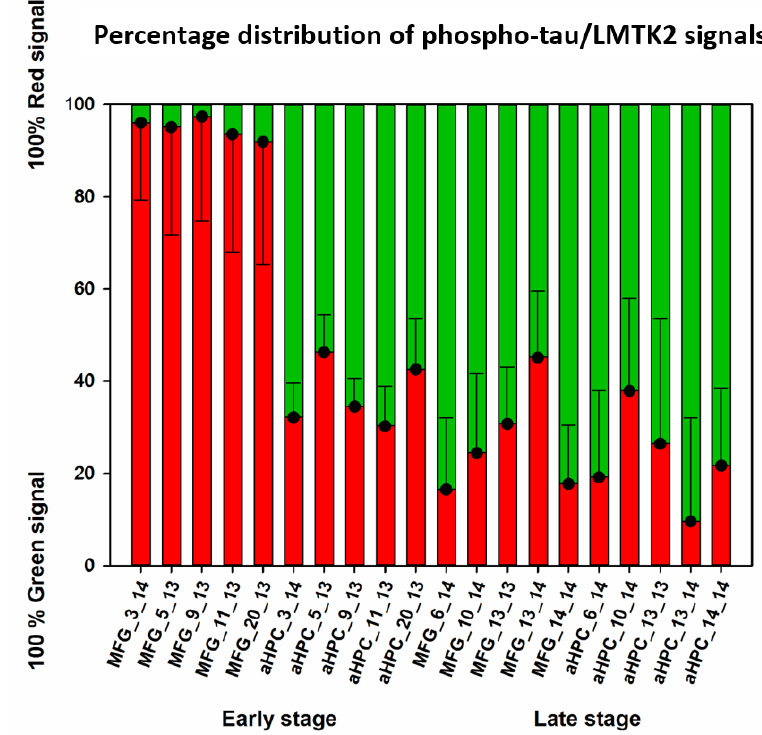
Figure 4. Bars depict the mean level (in %) of fluorescence for red (lemur tyrosine kinase-2 (LMTK2)) and green (phospho-tau) channels of images from the middle frontal gyrus (MFG) and anterior hippocampus (aHPC) in early and late neuropathological Braak tau stages.